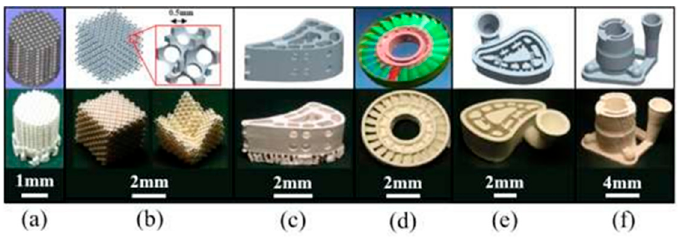
Figure 11. Advanced ceramic parts manufactured with SLM [90]: ( a ) porous bioceramic scaffolding; ( b ) photonic crystals; ( c ) hollow turbine blade; ( d ) impeller; ( e – f ) investment casting moulds.